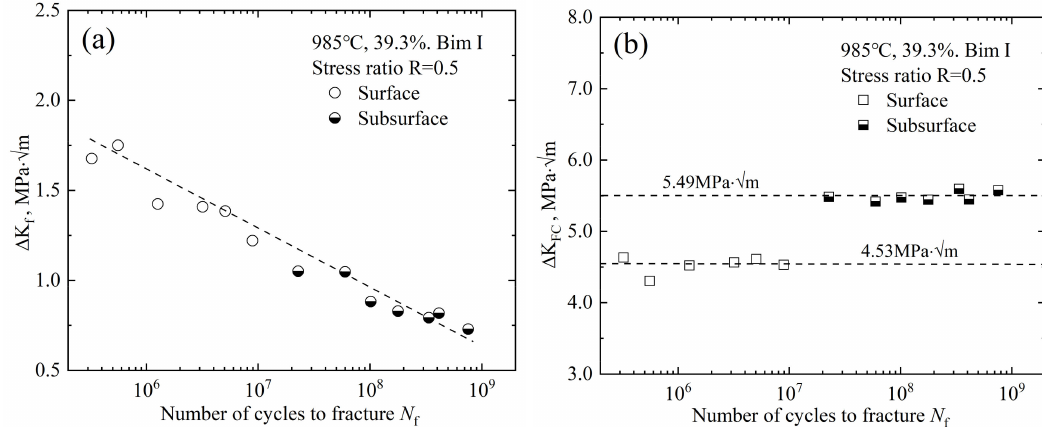
Figure 12. Calculation of stress intensity factor amplitude. ( a ) ∆ K f and N f ; ( b ) ∆ K FC and N f